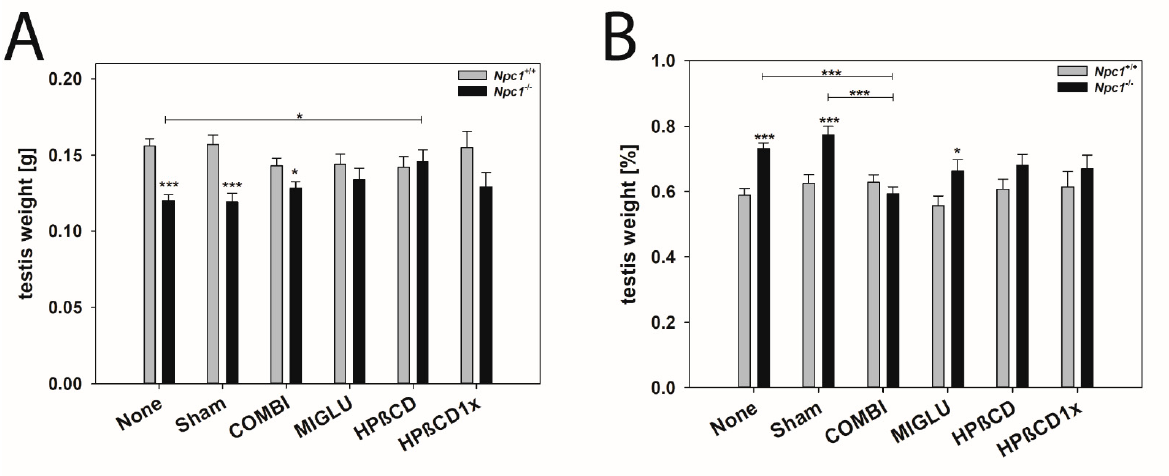
Figure 9. Testis weight ( A ) and relative testis weight ( B ) of Npc1 mice. Significant post-hoc tests are indicated by asterisks (* p < 0.05, *** p < 0.001). Data are means ± SEM.